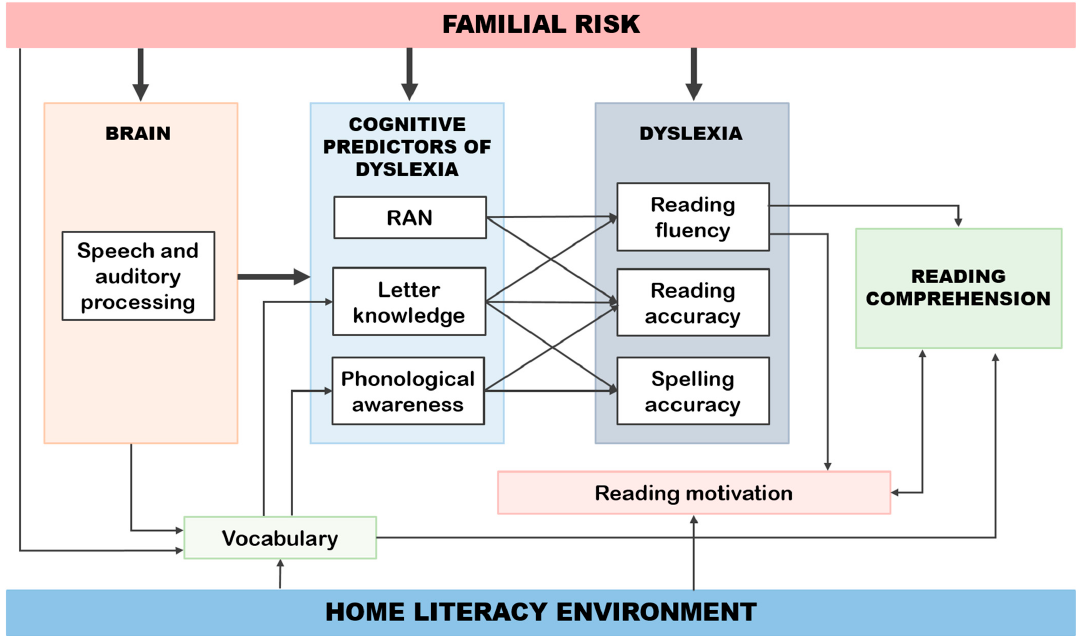
Figure 4. The predictive connections found between the key measures in the Jyväskylä Longitudinal Study of Dyslexia (JLD) project. The thick arrows denote connections to all individual skills or measures mentioned under the domain.